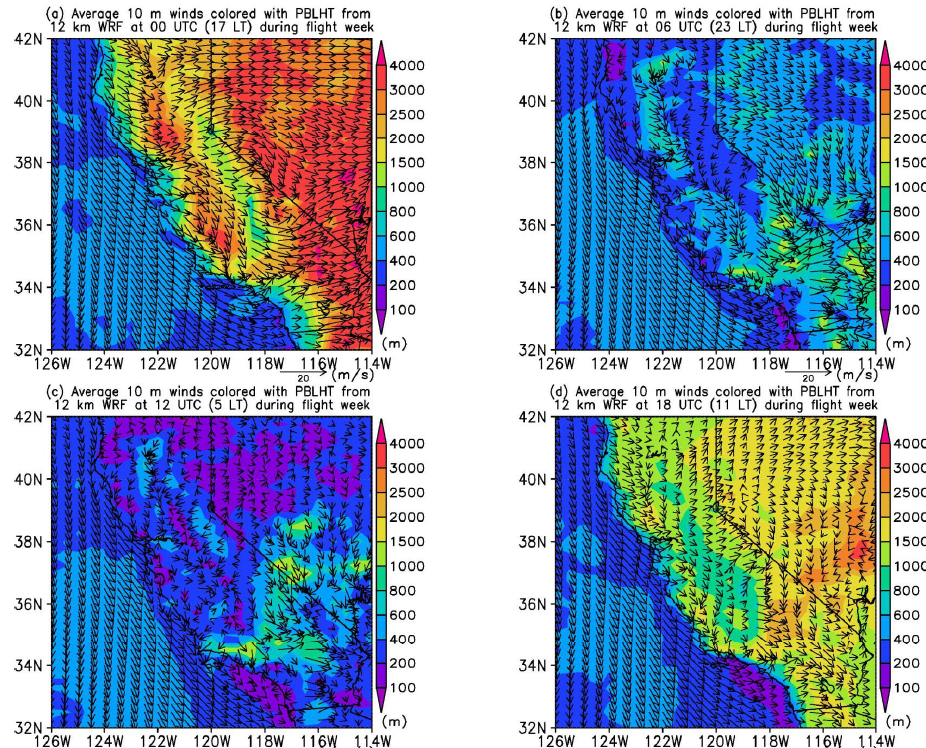
Figure 2 Weekly-average 12 km WRF 10 m wind fields, at (a) 00 UTC (17 local time) (b) 06 UTC (23 local time) (c) 12 UTC (5 local time) (d) 18 UTC (11 local time), overlaid on 12 km WRF-predicted mixing layer height (m). Fig. 2. Weekly-average 12km WRF 10 m wind fields, at (a) 00:00UTC (17:00local time) (b) 06:00UTC (23:00local time) (c) 12:00UTC (05:00local time) (d) 18:00UTC (11:00 local time), overlaid on 12km WRF-predicted mixing layer height